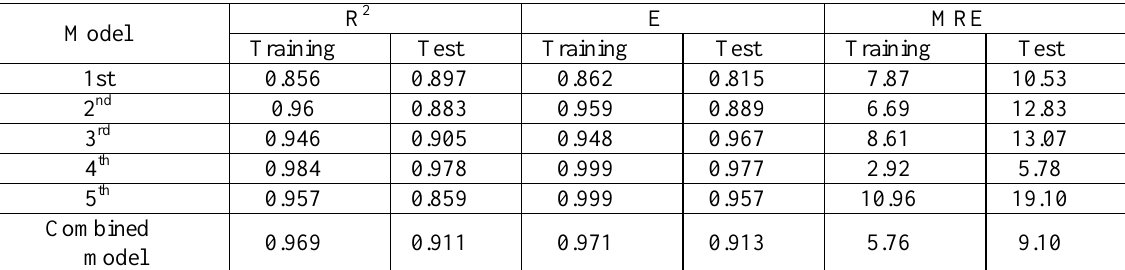
Fig. 9 Observed discharge versus predicted discharge for combined model: a) training data, b) testing data Table 1. The value of errors for